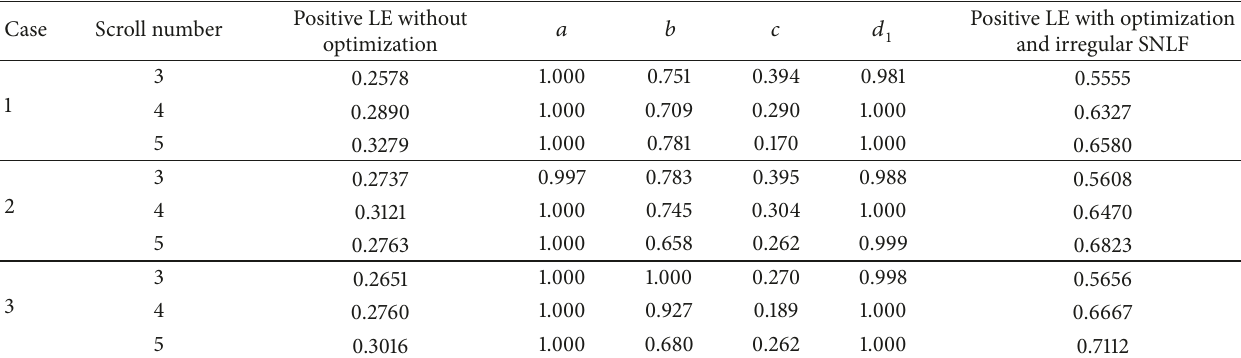
Table 4: Positive LEs for the optimized multiscrolls chaotic oscillators with different slopes 𝑘 V as the cases listed in Table